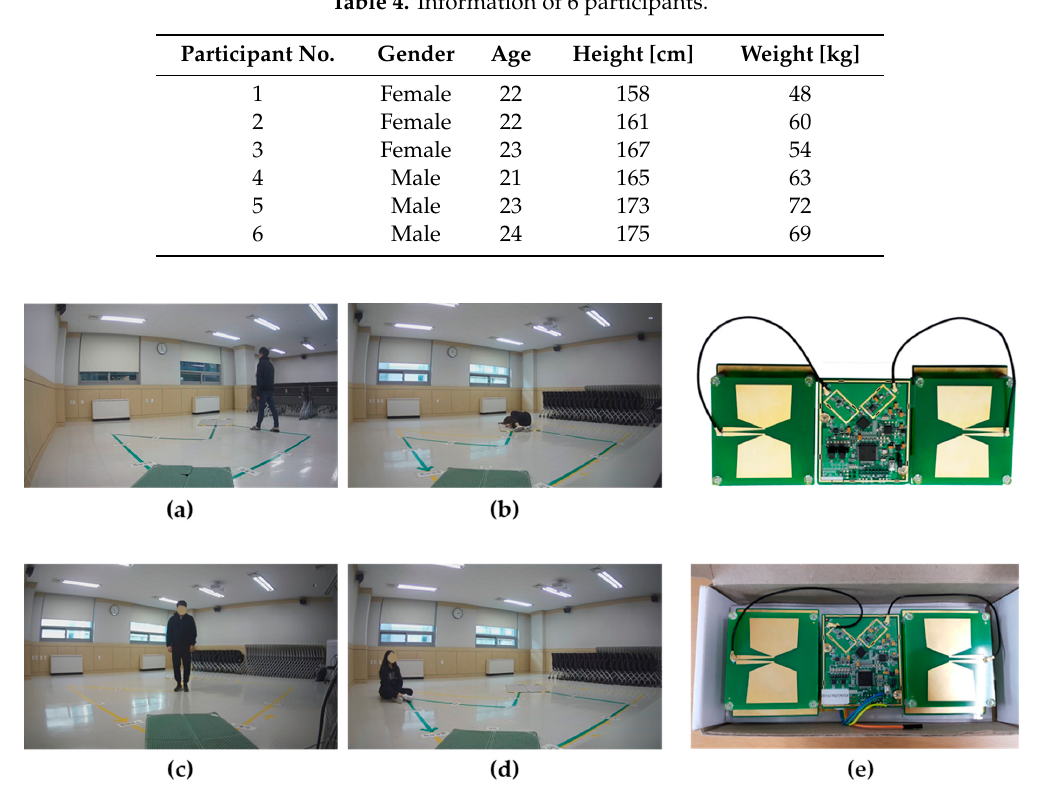
Figure 12. Pictures of di ff erent types of behavior performed in the experiment: ( a ) walking, ( b ) fall, ( c ) standing and ( d ) sitting and ( e ) U-MAIN HST-S1M-SE radar sensor.